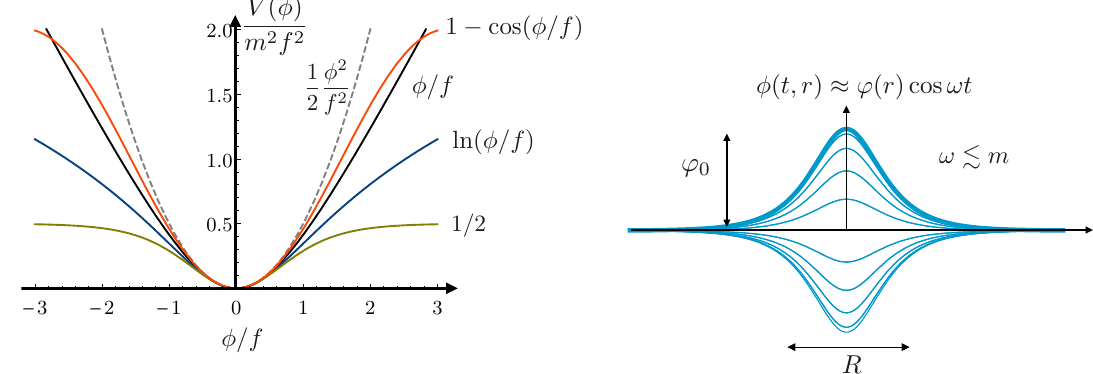
Figure 1 . Left: the scalar field potentials that support solitons. For the quadratic potential and cosine potential, gravity is essential for supporting long-lived solitons, whereas the “flattened” potentials can support solitons without gravity, but typically require amplitudes ∼ f . For any potential where solitons have a small amplitude compared to f , gravity is essential for long-lived stable solitons. Right: a schematic representation of a solitons. Dilute solitons have ϕ R (cid:29) m − 1 . Dense solitons have ϕ 0 ∼ f and R ∼ few × m − 1 . The frequency is always ω . m